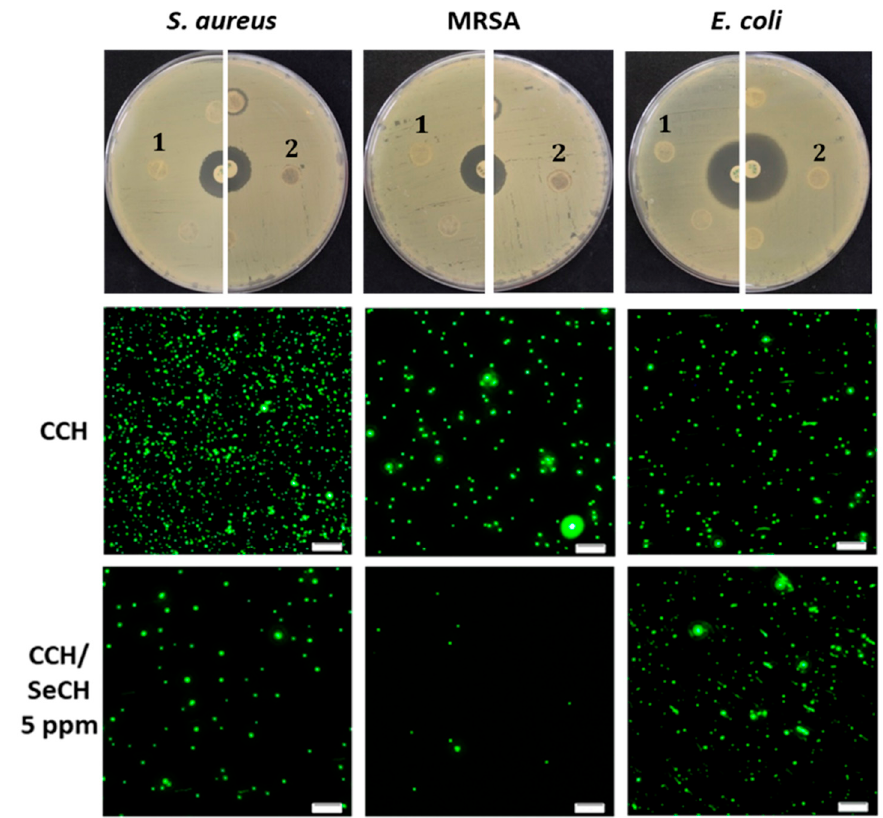
Figure 9. Top row: digital photograph of the disk di ff usion method for Staphylococcus aureus ( S. aureus ), methicillin-resistant Staphylococcus aureus (MRSA) and Escherichia coli ( E. coli ) with sca ff olds: CCH (1), CCH / SeCH 5 ppm (2), and antibiotic as the positive control (PC). Second and third row: fluorescence microscopy of bacterial cells (SYTO9, green) obtained from sca ff olds used in the disk di ff usion method; the scale bar is 20 µm.